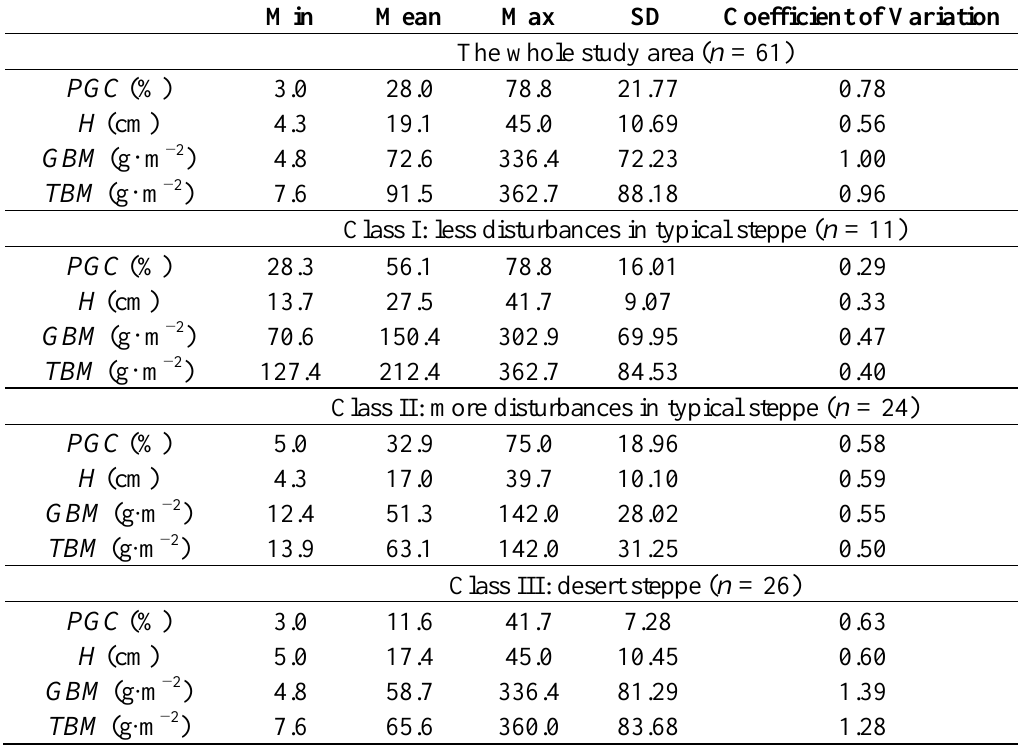
Table 1. Summary statistics of the biophysical characteristics from 61 sampled communities in Inner